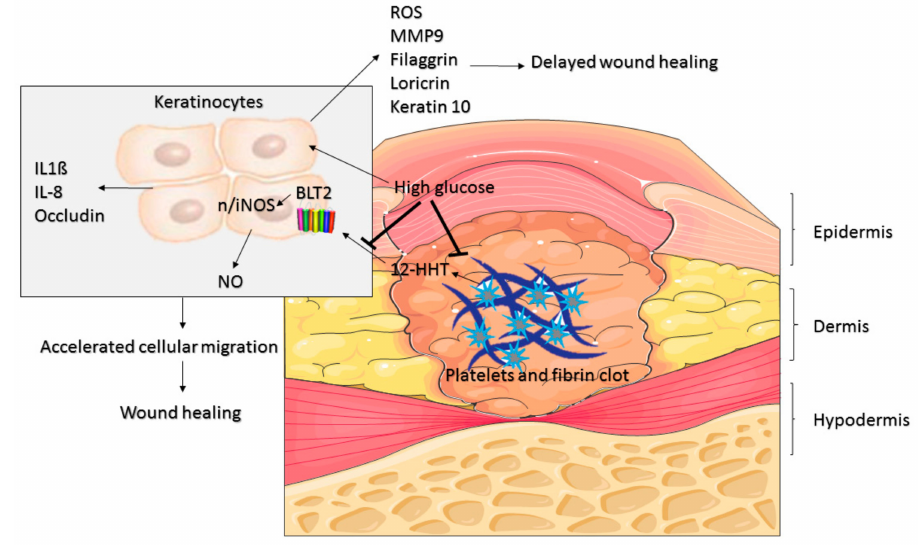
Figure 6. Proposed model of 12-HHT / BLT2 / NO action in wound